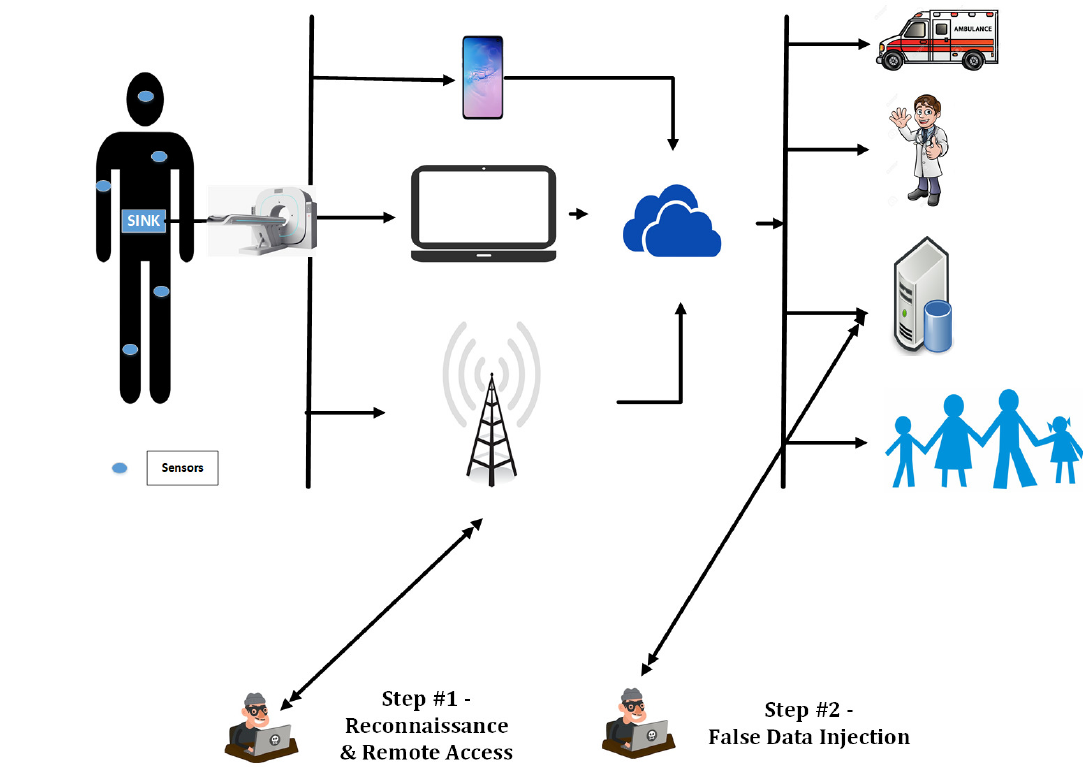
Figure 1. Conceptual view of False Data/Image Injection in the Internet of Medical Things